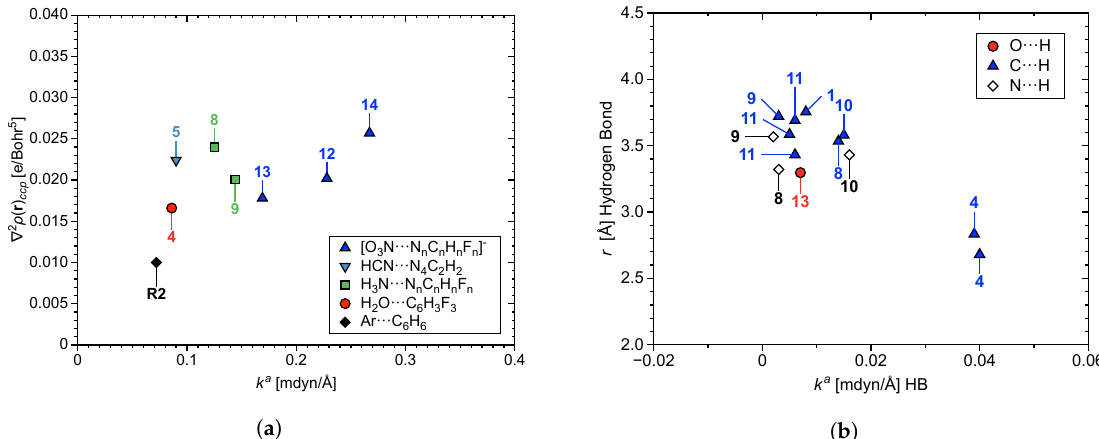
Figure 6. ( a ) The Laplacian of the electron density at the CCP ( ∇ 2 ρ ( r CCP ) ), and ( b ) r of the HBs; both plotted with respect to k a of π –hole interactions in 1–14 and R2 .